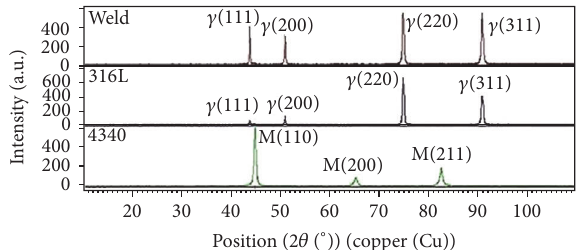
Figure 15: The XRD pattern from weld zone (sample number 3) and base metals.